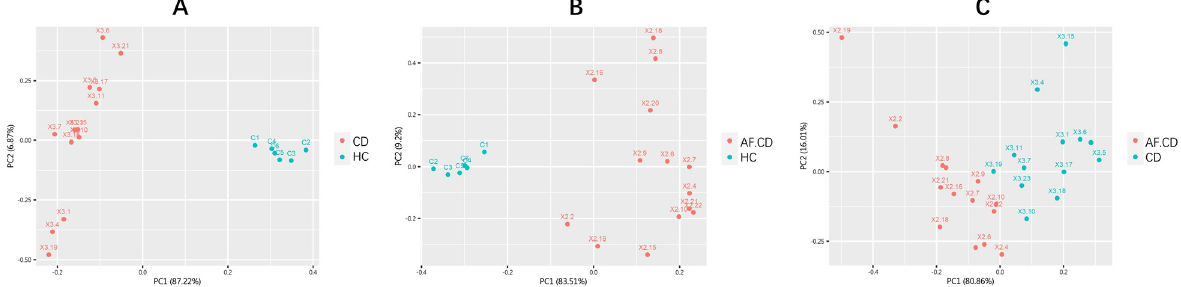
Figure3: Principalcomponentanalysis(PCA)analysisbetweenanalfistulawithchronicdiarrheapatientsandhealthycontrolgroup(A)based on 34 DEPs, chronic diarrhea patients and healthy control groups based on 33 DEPs (B), and anal fi stula with chronic diarrhea patients and chronic diarrhea patient groups based on three DEPs (C). Each spot represents a single sample and different color means different sample group. AF.CD, anal fistula with chronic diarrhea; CD, chronic diarrhea; HC, healthy control.